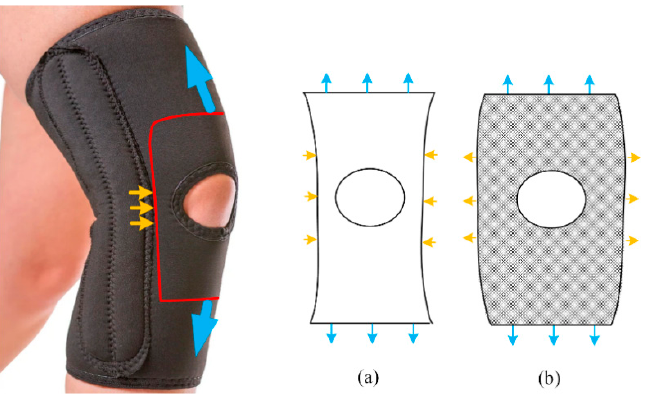
Figure 1. The negative Poisson’s ratio effect of protective gear. ( a ) Tensile effect of ordinary materials. ( b ) Tensile effect of negative Poisson's ratio material.